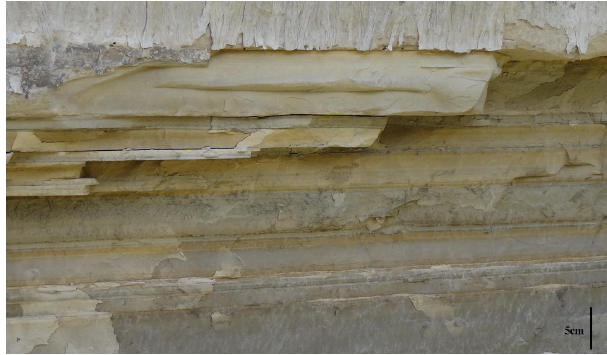
Fig. 4 . Structure of lacustrine sediment in the Diexi barrier lake Figure 4. Structure of lacustrine sediment in the Diexi barrier